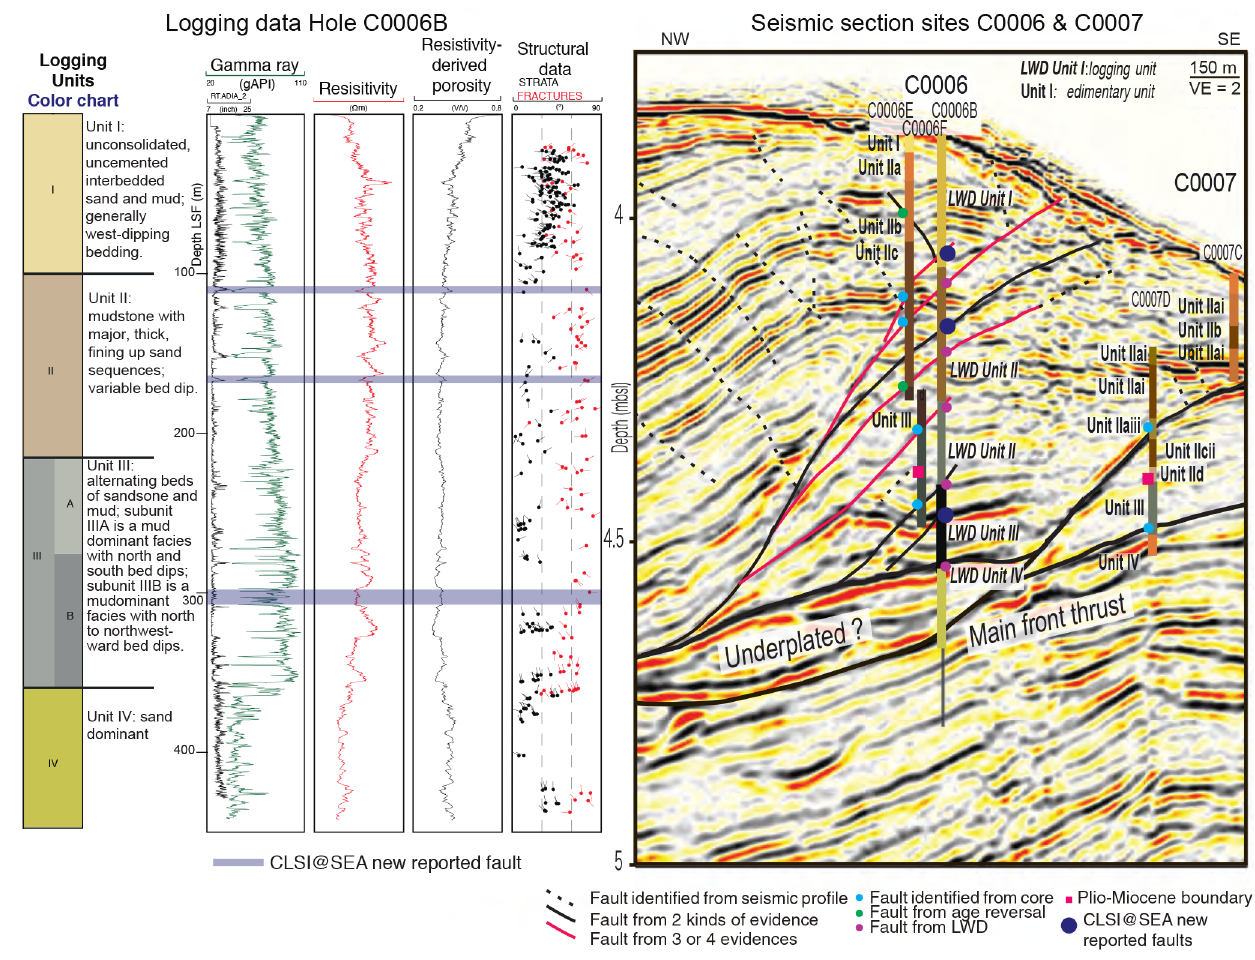
Figure 4. Sedimentary, logging and seismic data at the deformation front of the Nankai prism (Sites C0006 and C0007). Dark blue markers (strips, dots) are additions provided by the CLSI@Sea workshop. The figure shows (from left to right) the logging data at Hole C0006B, the interpreted seismic section (IL 2435) across the Nankai 3-D volume illustrating the structures at the deformation front, and the lithological units and the logging units identified at both Sites C0006 and C0007. Some structures (dark blue) have been identified by integration of the Core-Logging-Seismic data. Figure compiled and modified from Kimura et al. (2008) and Kinoshita et al. (2008,